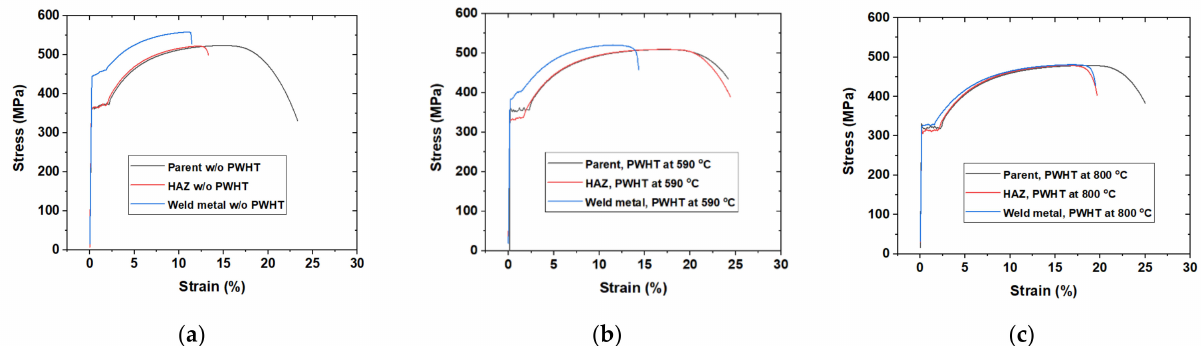
Figure 9. Comparison of tensile curves of parent, HAZ and weld metal. ( a ) Non PWHT ( b ) PWHT at 590 ◦ C; ( b ) PWHT at 590 ◦ C; ( c ) PWHT at 800 ◦